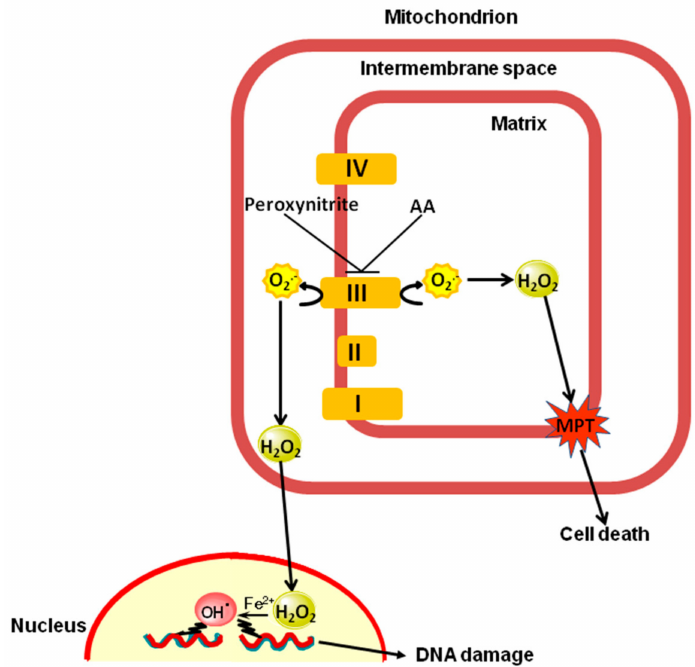
Figure 6. The enhancing effects mediated by the mitochondrial fraction of AA in cells exposed to peroxynitrite: proposed mechanism. AA increases the vulnerability of complex III to peroxynitrite via a Ca 2+ -independent mechanism. The extramitochondrial effects observed under these conditions are caused by superoxide released by complex III in the intermembrane space, which readily dismutates to a diffusible species, H 2 O 2 . The intramitochondrial effects are instead mediated by superoxide formation in the matrix followed by its conversion to H 2 O 2